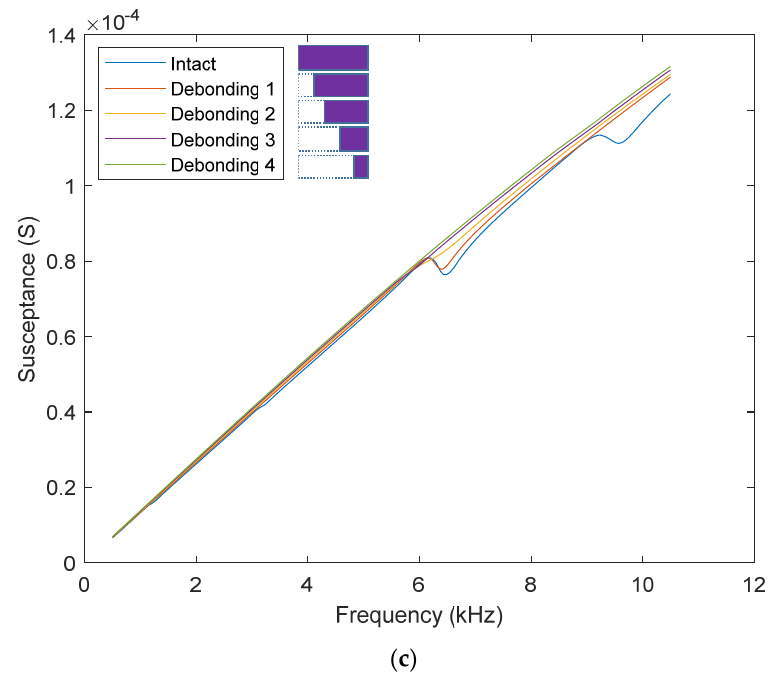
Figure 11. Impedance response: PZT bebonding simulation. ( a ) Resistance; ( b ) Reactance; ( c ) Susceptance.